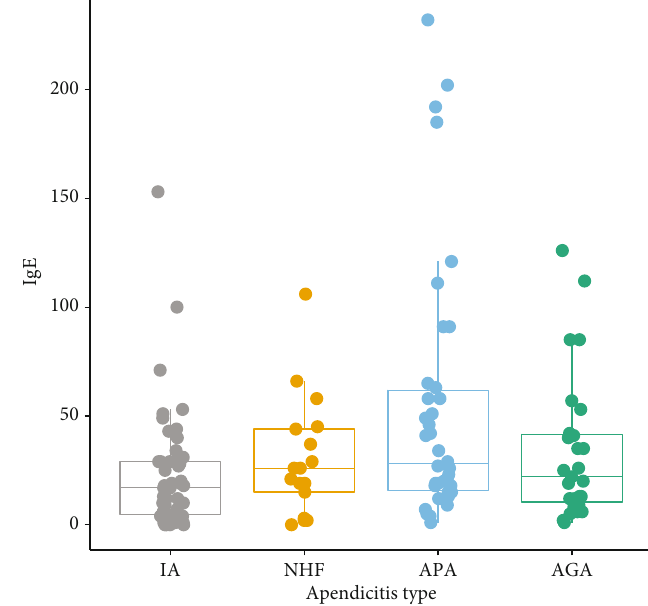
Figure 4: IgE levels according with appendicitis